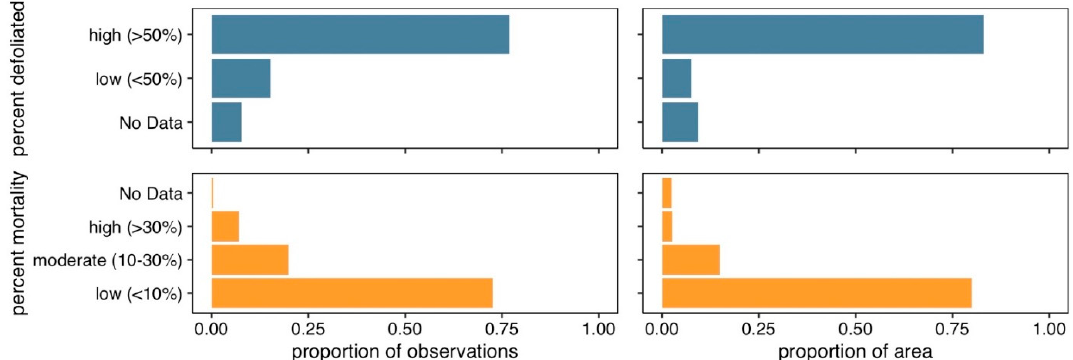
Figure A4. The proportion of ADS observations and area of ADS polygons by damage severity, characterized by percent defoliated for WSB ( top ) and percent mortality for DFB ( bottom ).